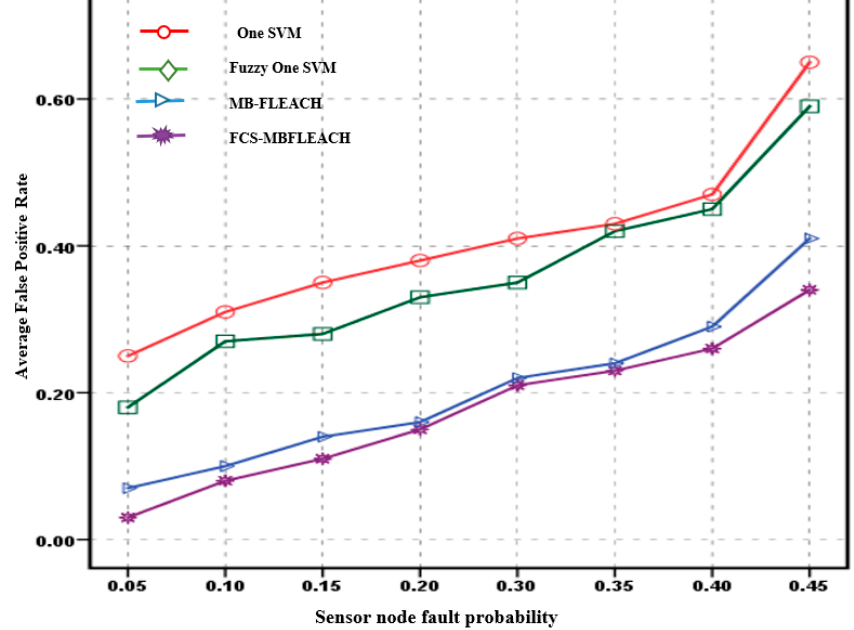
Figure 11. Average false positive rate for sensor node faults with a density equal to five for the first scenario.